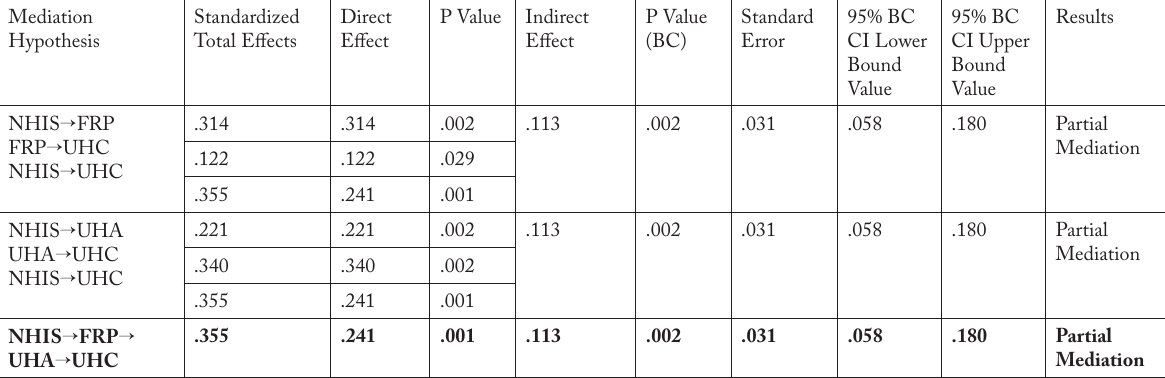
Table 10. Mediation effect test.